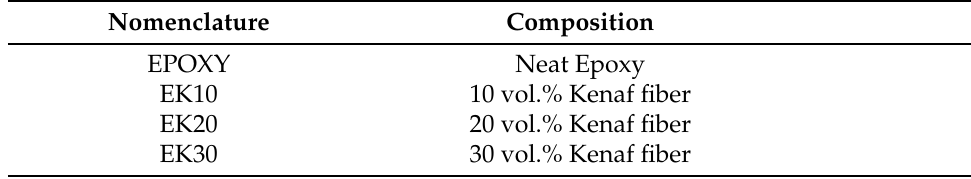
Figure 2. Samples for DMA testing: ( a ) epoxy resin; ( b ) 10 vol%, ( c ) 20 vol% fibers and ( d ) 30 vol% fibers. Table 1. Nomenclature of the composites used in this